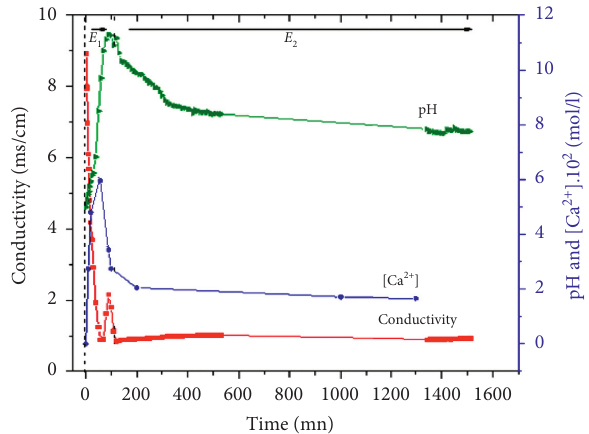
Figure 4: Evolution of the conductivity, pH, and Ca 2+ concen- tration for mixture M